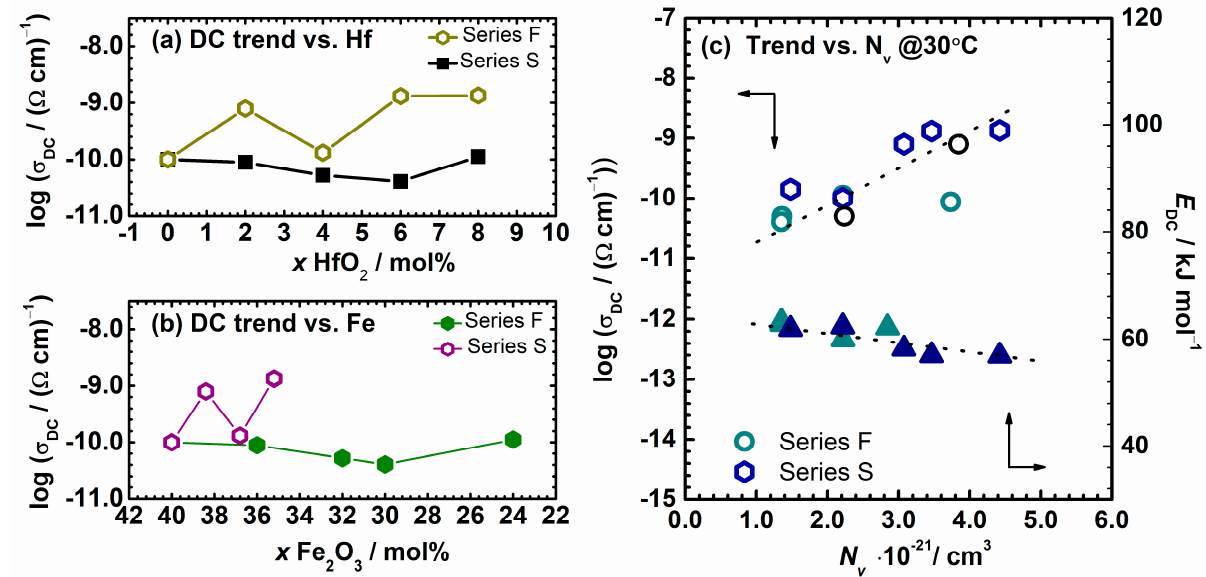
Figure 3. DC conductivity at 30 °C and activation energy for DC conductivity, E DC , as a function of ( a ) HfO 2, ( b ) Fe 2 O 3, and ( c ) the number density of polarons, N v , for both series. Additionally, two black circle symbols in ( c ) are the experimental data for two samples from this study, with N v calculated based on Mössbauer data reported in reference [44]. The error bars are, at most, of the order of the symbol size. Lines are drawn as guides for the eye.